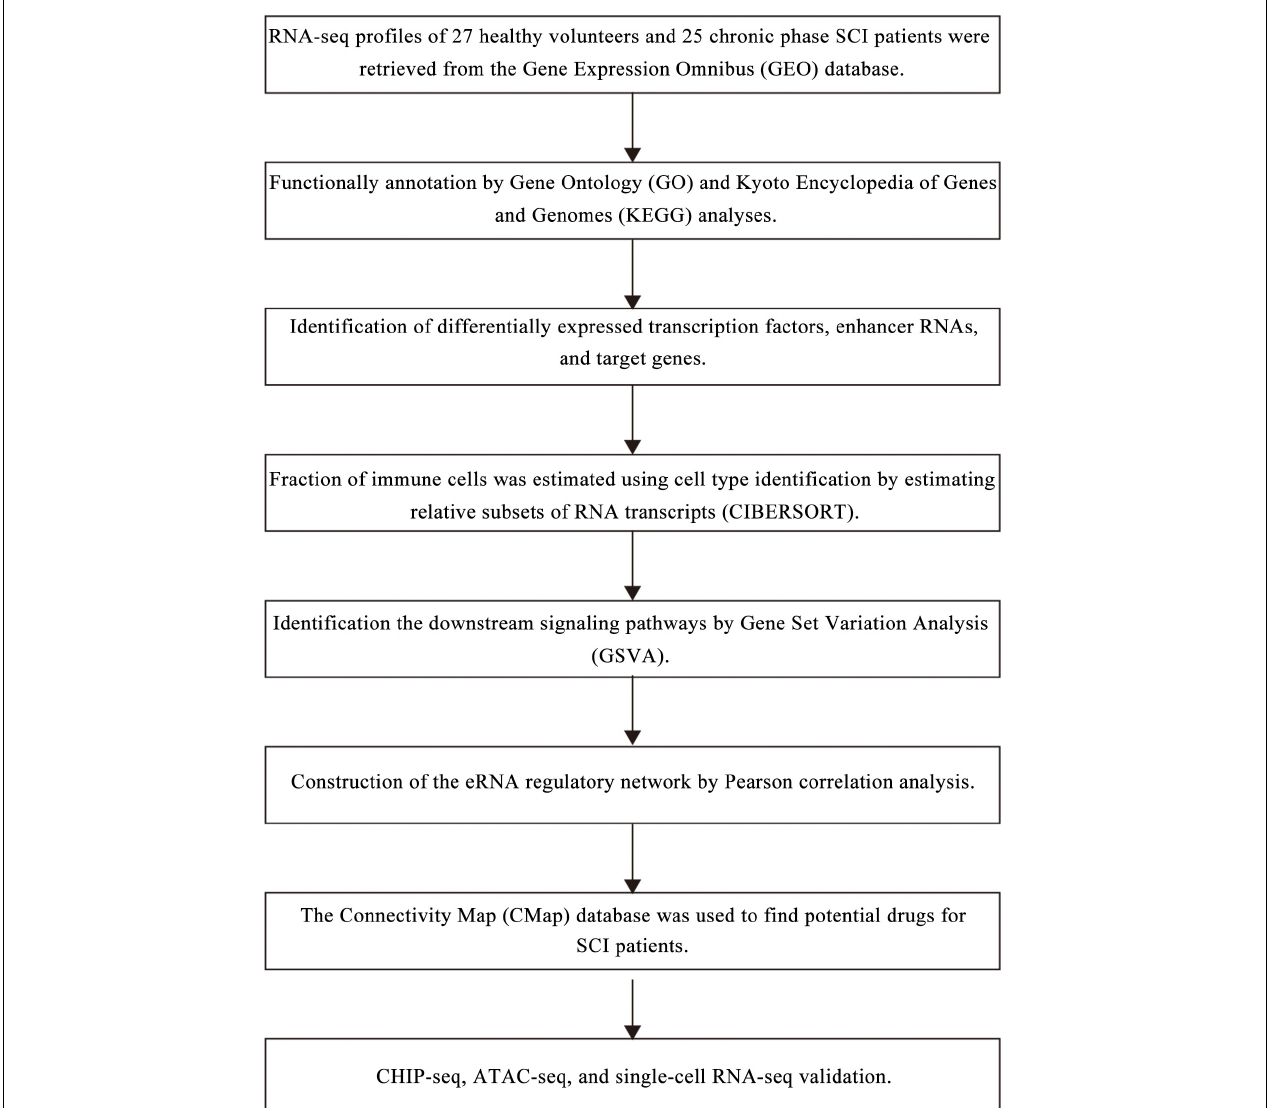
FIGURE 1 | The analysis flowchart of all analysis